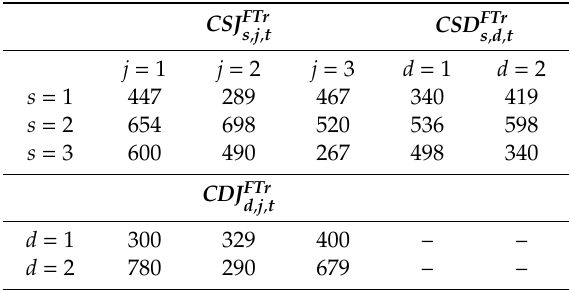
Table A10. Fixed transportation cost ( € ) (considered here the same for any t ).